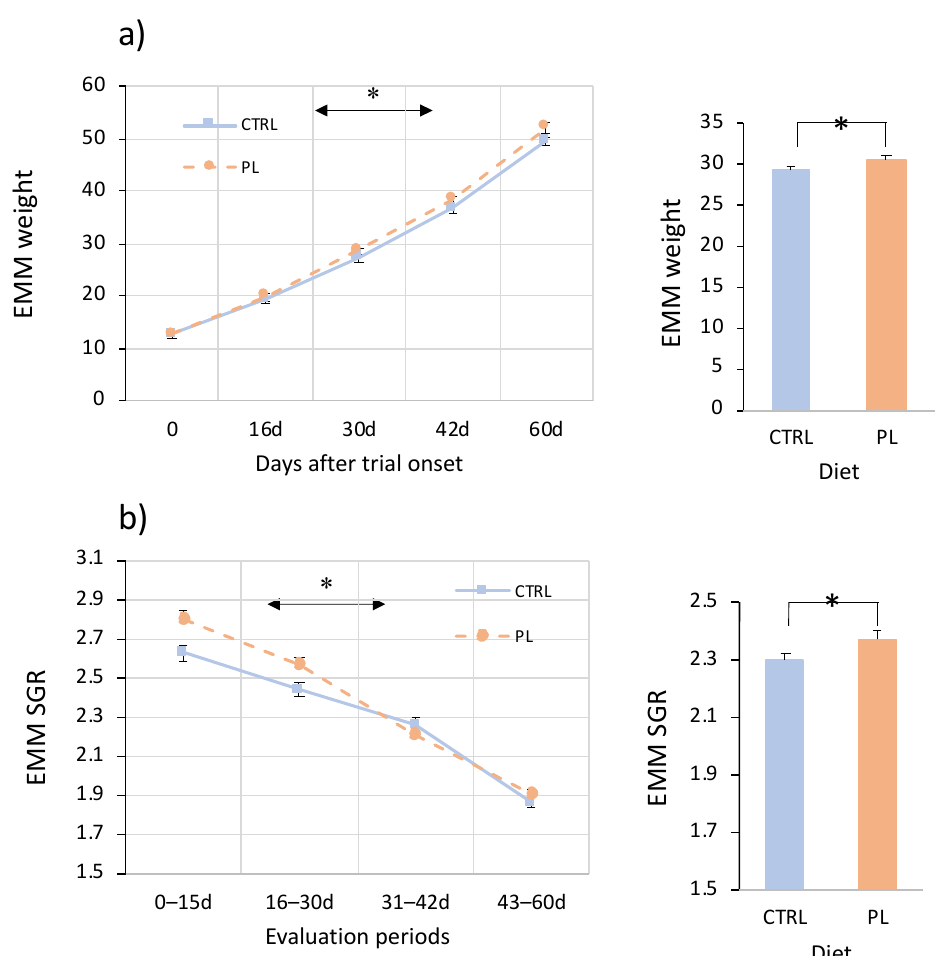
Figure 2. Weight ( a ) and specific growth rates (SGR) ( b ) of animals fed with the control (CTRL, blue) or PL-enriched (PL, orange) diets. Lines represent the estimated marginal means (EMM) after a repeated measures ANOVA using the weight at different samplings or the SGR in the evaluation periods. Asterisks on the horizontal denote if within-subjects for interaction diet × time are statistically significant. Bars on the right represent the EMM for weight and SGR in the whole period. Asterisks denote if between-subjects are statistically significant. Table 2. Wet weight (g) and temperature at death (Tdeath) of meagre fed with the CTRL and PL-enriched diets. Data for the two cold challenges (named as 1 and 2) are indicated.